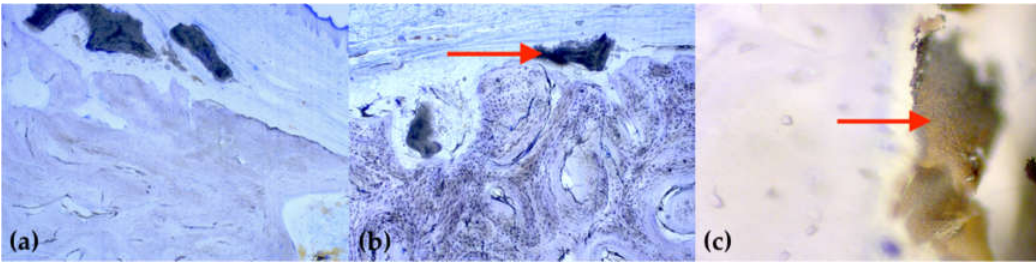
Figure 5. Exemplary illustration of attached or embedded bone substitute material: ( a , b ) isolated BEGO OSS particles (marked by arrow) are still found sporadically on the surface of all animals (staining: toluidine blue; magnification: 25x); ( c ) in cancellous bone, foreign material can only be observed in a very limited quantity (staining: toluidine blue; magnification: 400x). The cortical thickness in the area of the extraction sockets varied intra- and interindividually.